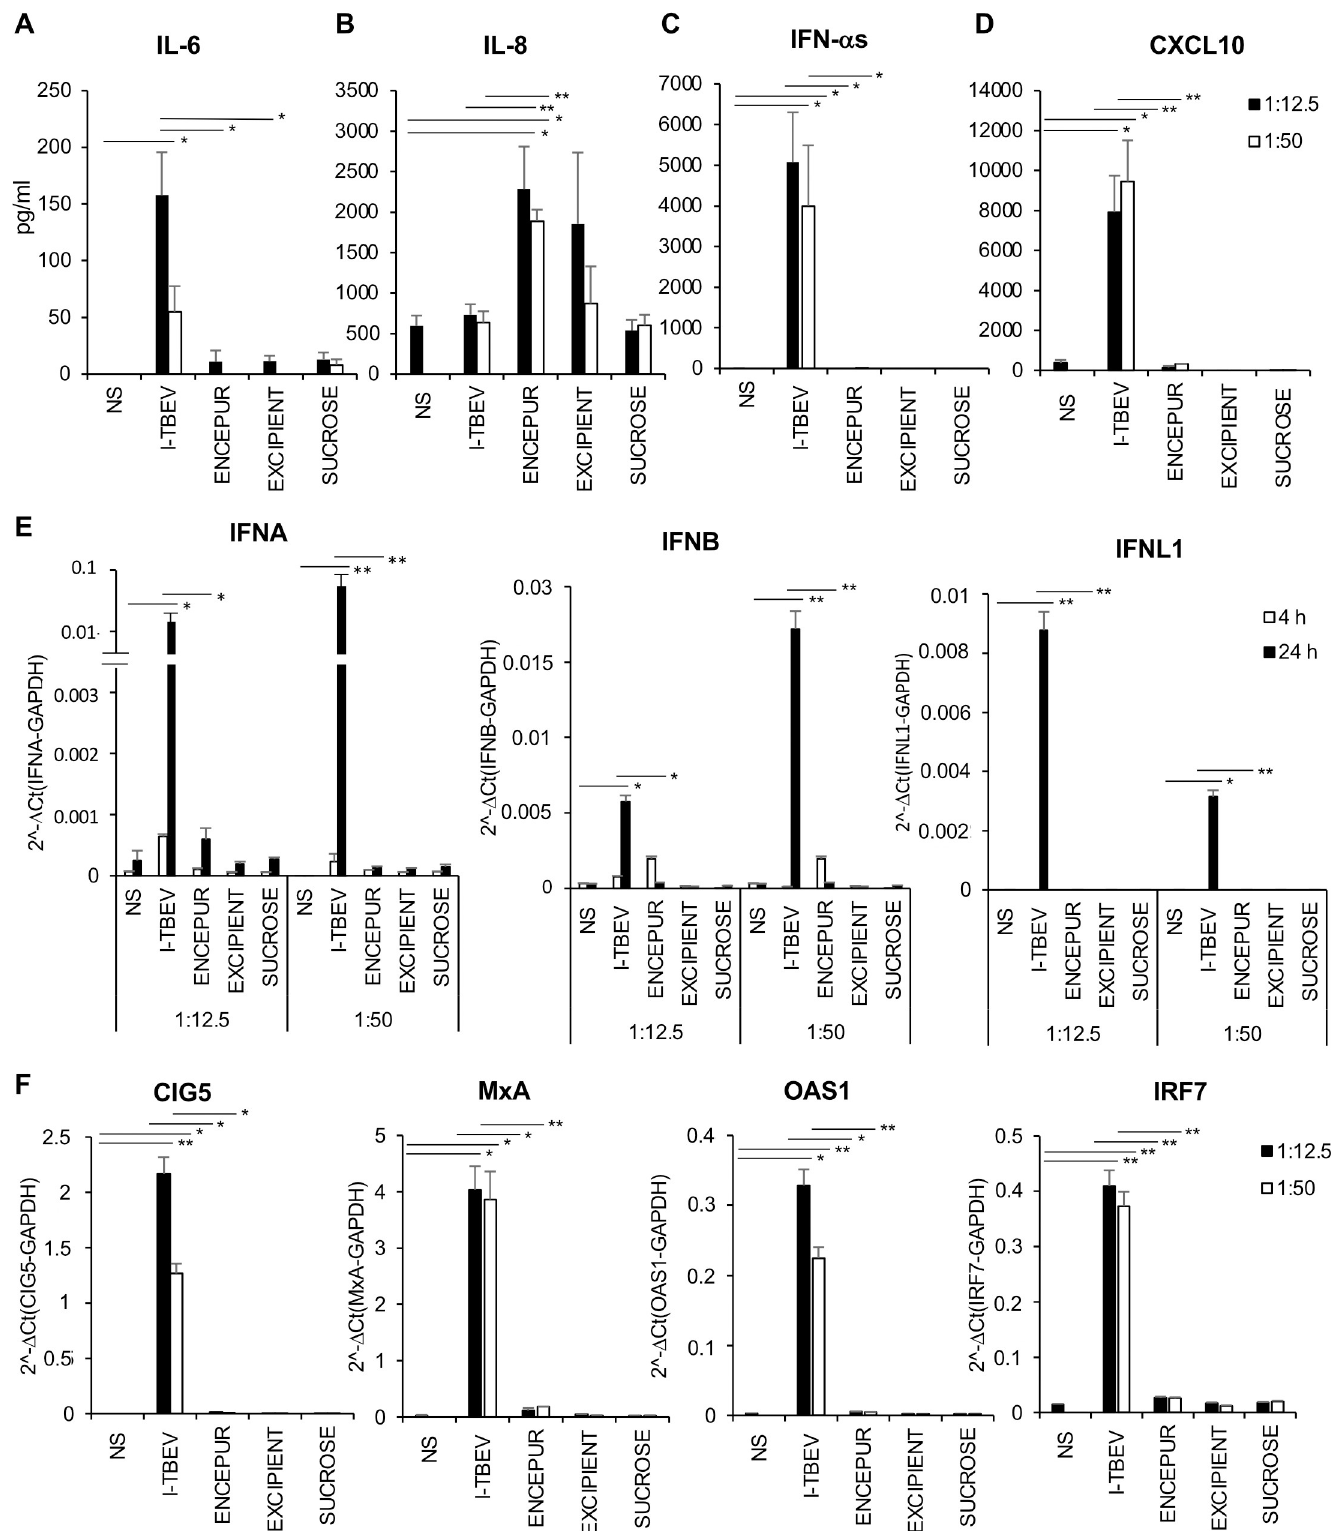
Fig 1. Cytokine and chemokine release in PBMC cultures stimulated with Encepur and single vaccine components. PBMC were stimulated for 4 and 24 hours with inactivated TBEV (I-TBEV), Encepur vaccine, excipient and sucrose (dilution 1:12.5 and 1:50) or left untreated (NS). The production of IL-6 (A), IL-8 (B), IFN- α